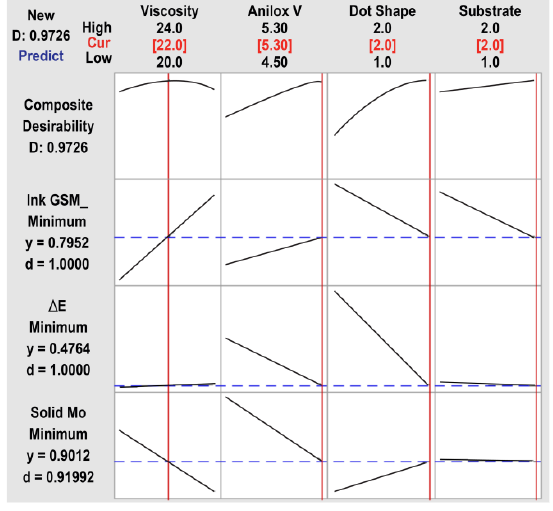
Figure 14. Optimization plot for the responses Table 9. Comparison of the mean-field